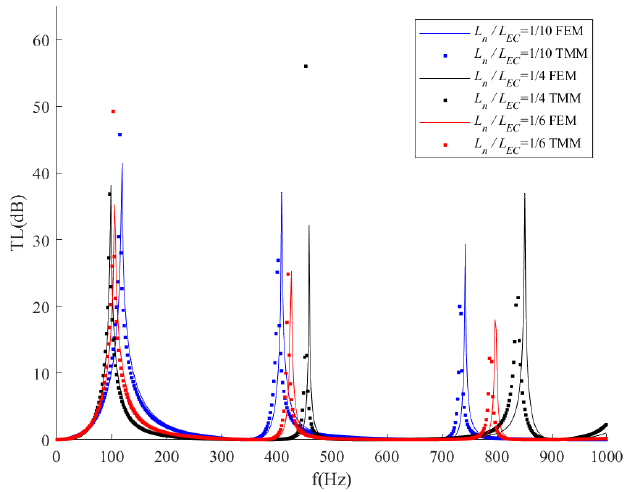
Figure 7. Comparison of transmission loss with respect to different length ratios of the expansion chamber. Table 3. Parameters of L N and L EC of ITECs in Figure